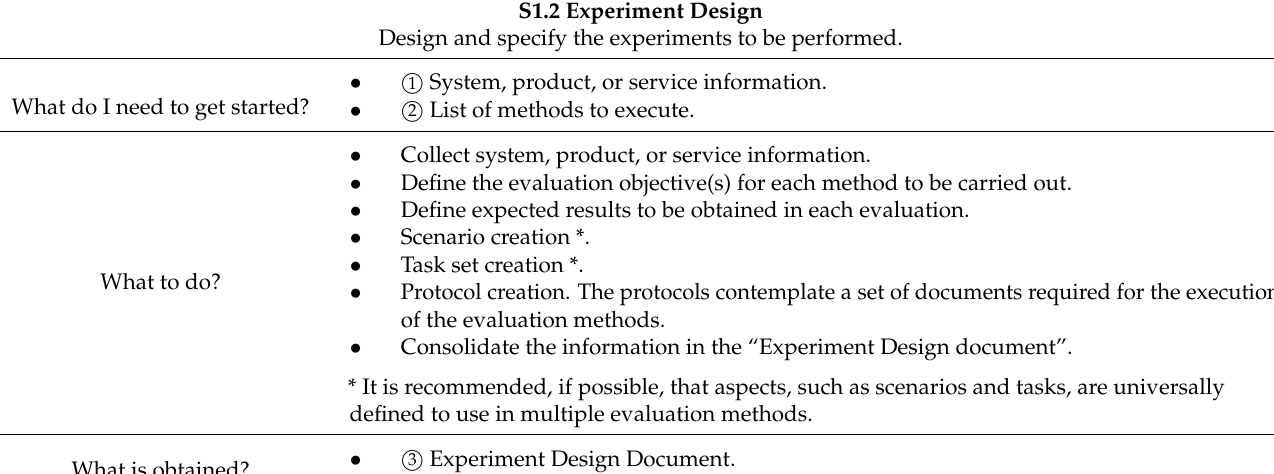
Table A4. Experiment Design